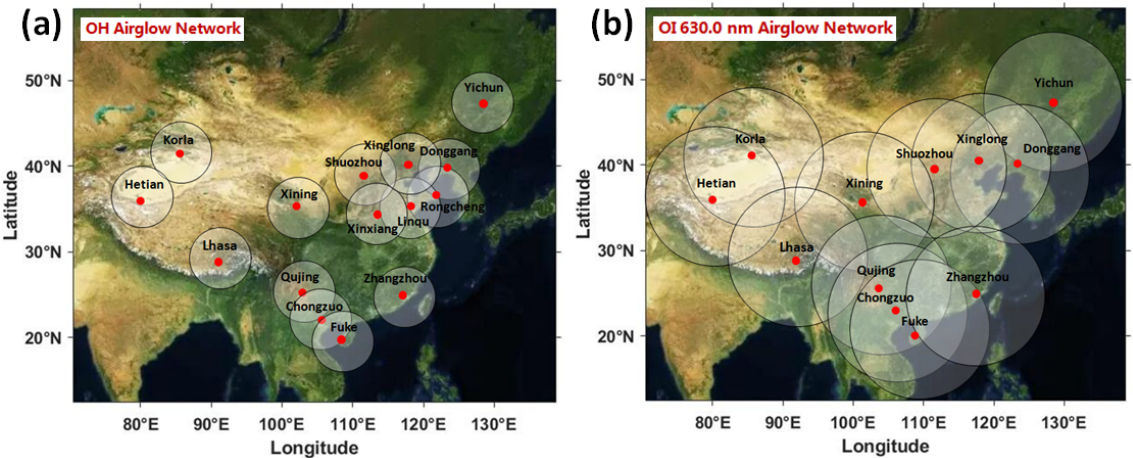
Figure 1. (a) OH airglow all-sky imager network (15 stations). (b) Red-line (630nm) airglow all-sky imager network (12 stations). The circles on the maps give the effective observation ranges of OH and red-line airglow imagers with diameters of about 800 and 1800km, respectively.